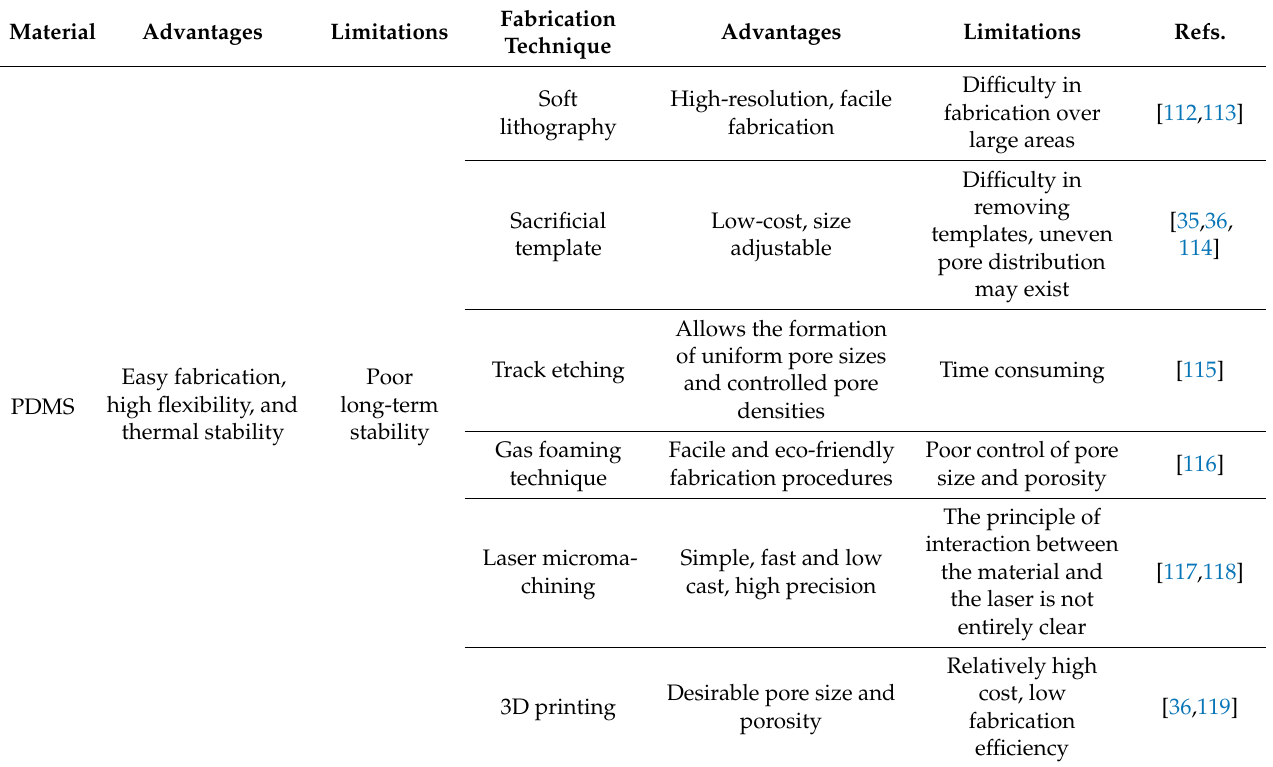
Table 1. Comparison of preparation methods and their advantages and disadvantages for different materials.